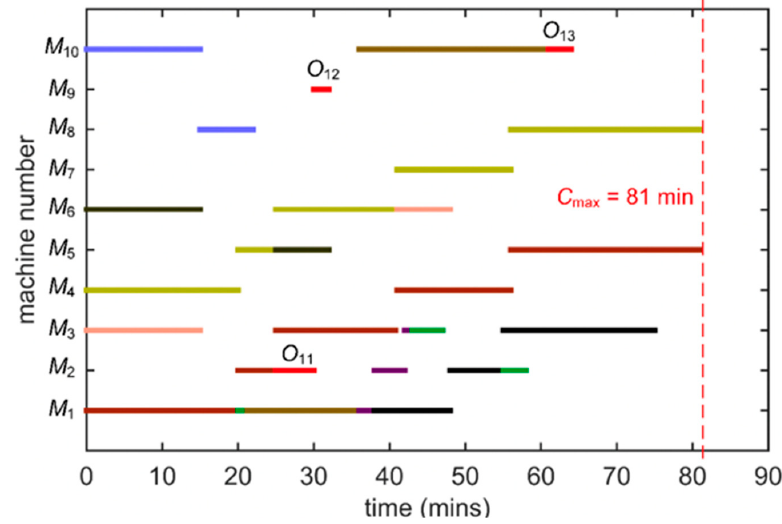
Figure 4. Gantt chart from ACO algorithm.